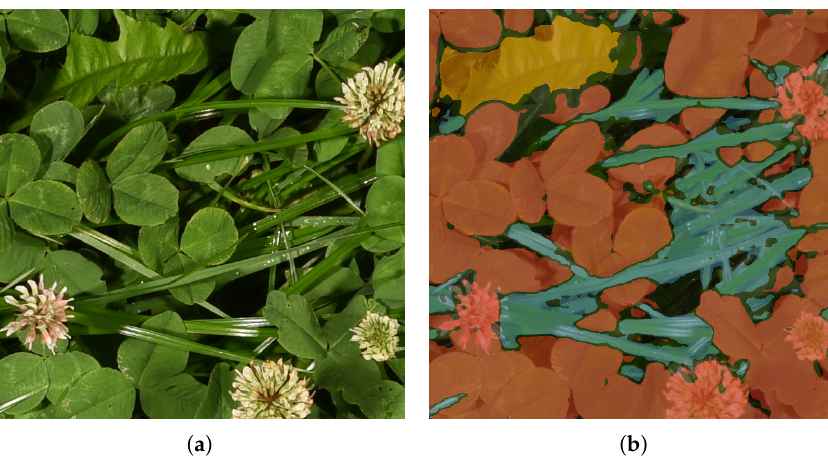
Figure 1. Example of the image analysis on a real image. Each pixel in the image is automatically analyzed and classified as either grass (blue), clover (red), weeds (yellow), or unidentified (black overlay). ( a ) Example input image; ( b ) Automatically analyzed